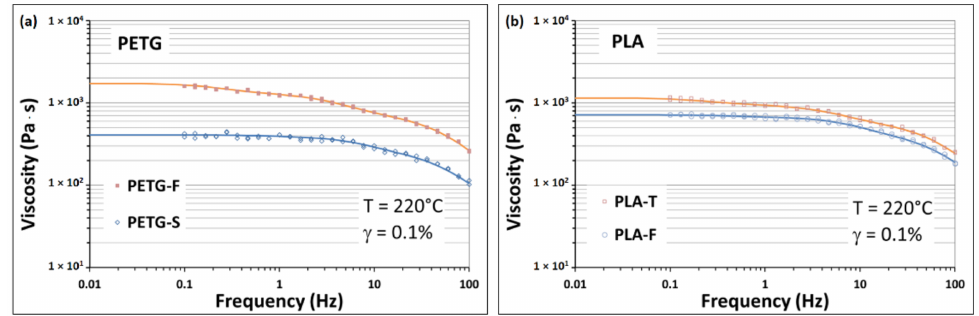
Figure 3. Rheological characterisation of ( a ) PETG and ( b ) PLA